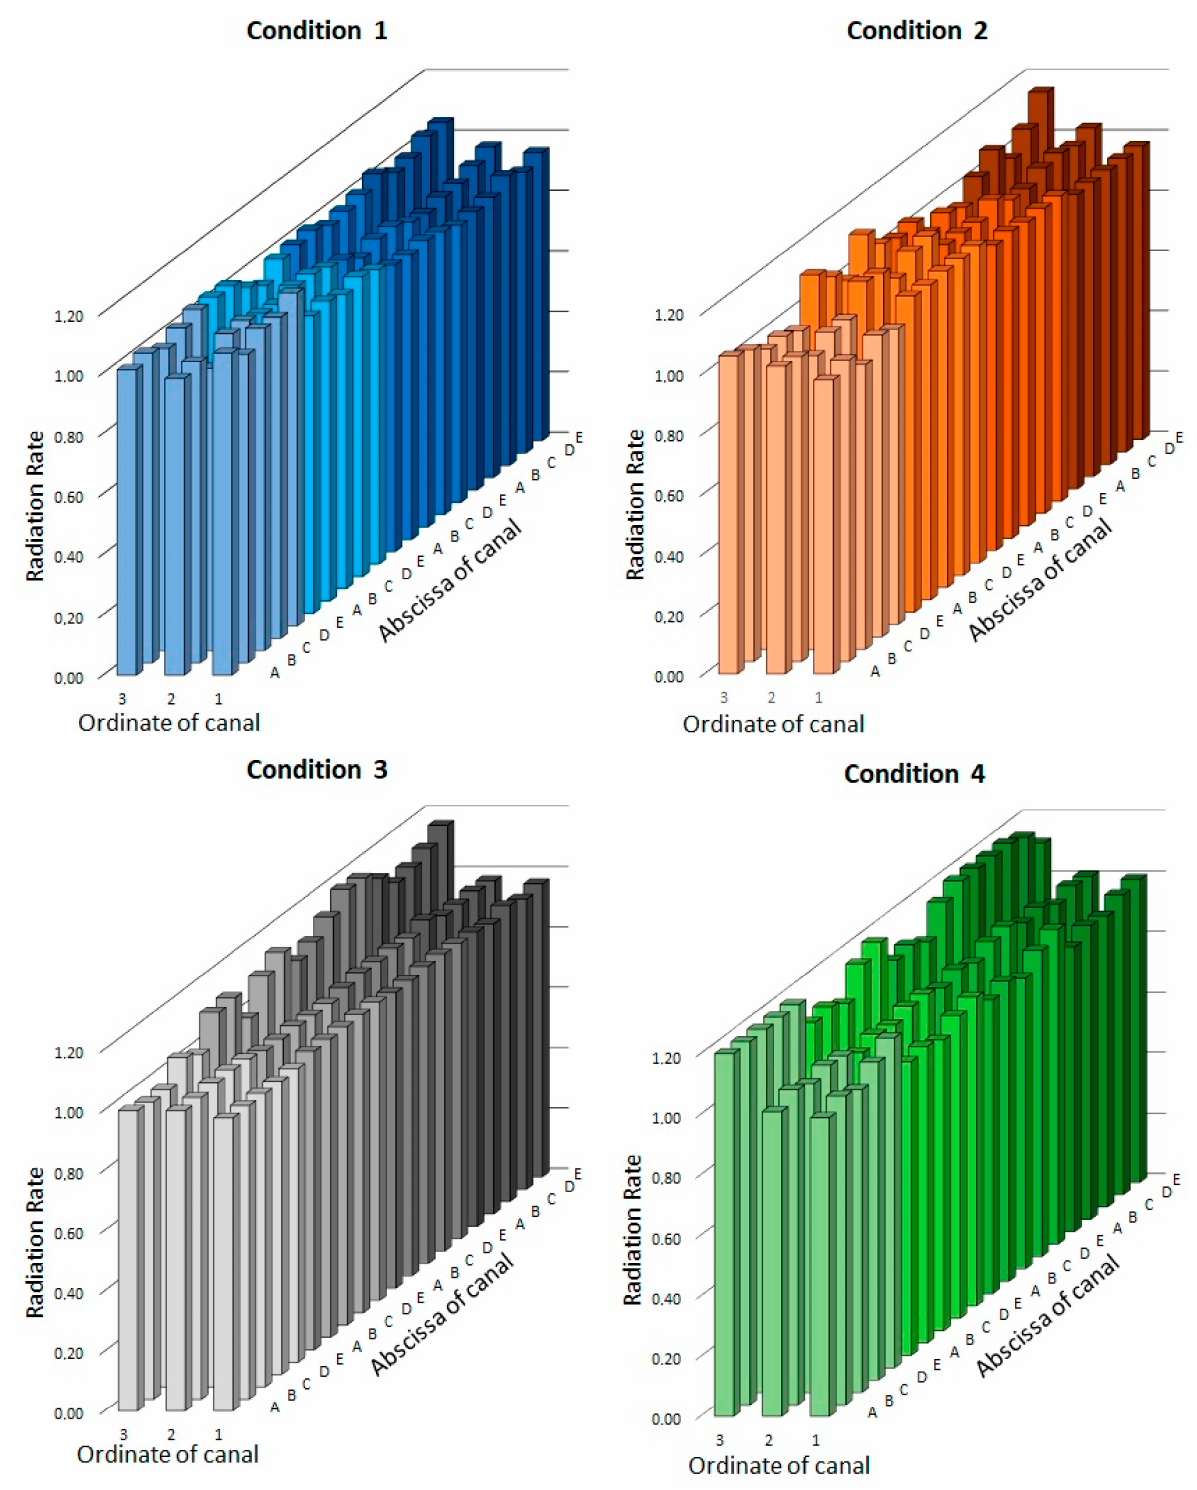
Figure 4. Graphic representation of estimated radiation ratios.